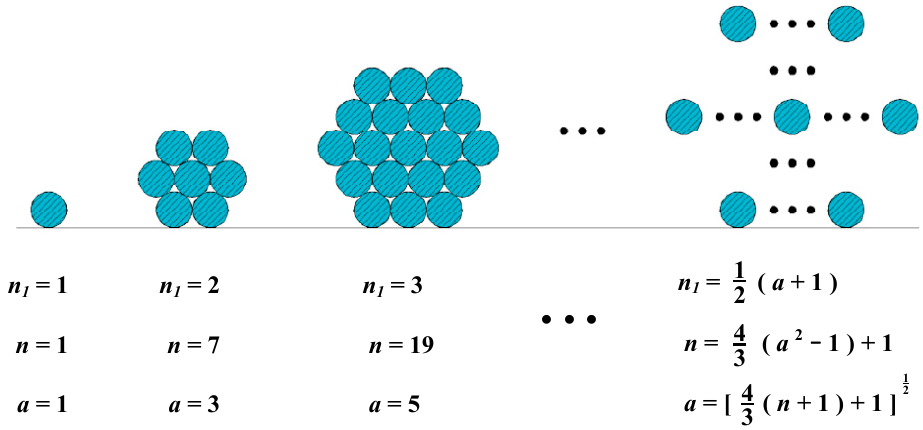
Figure 3. Arrangement of the CFRP cable section.